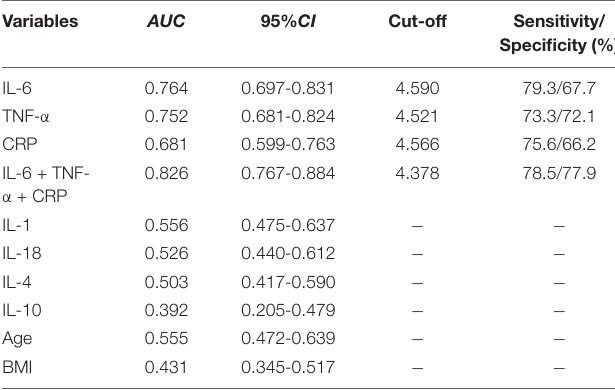
TABLE 2 | Performance of depression prediction using inflammatory cytokines.